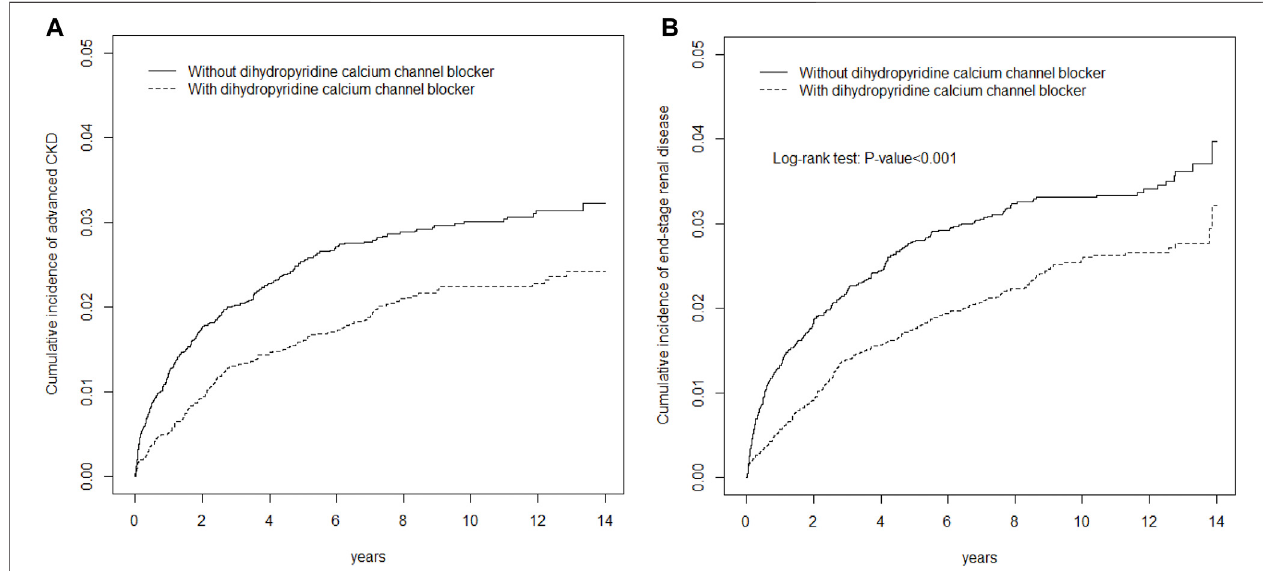
FIGURE 1 | Cumulative incidence of EPO (A) or ESRD (B) curves for dihydropyridine calcium channel blocker (DCCB) users and dihydropyridine calcium channel blocker (DCCB) non-users by propensity score matched.